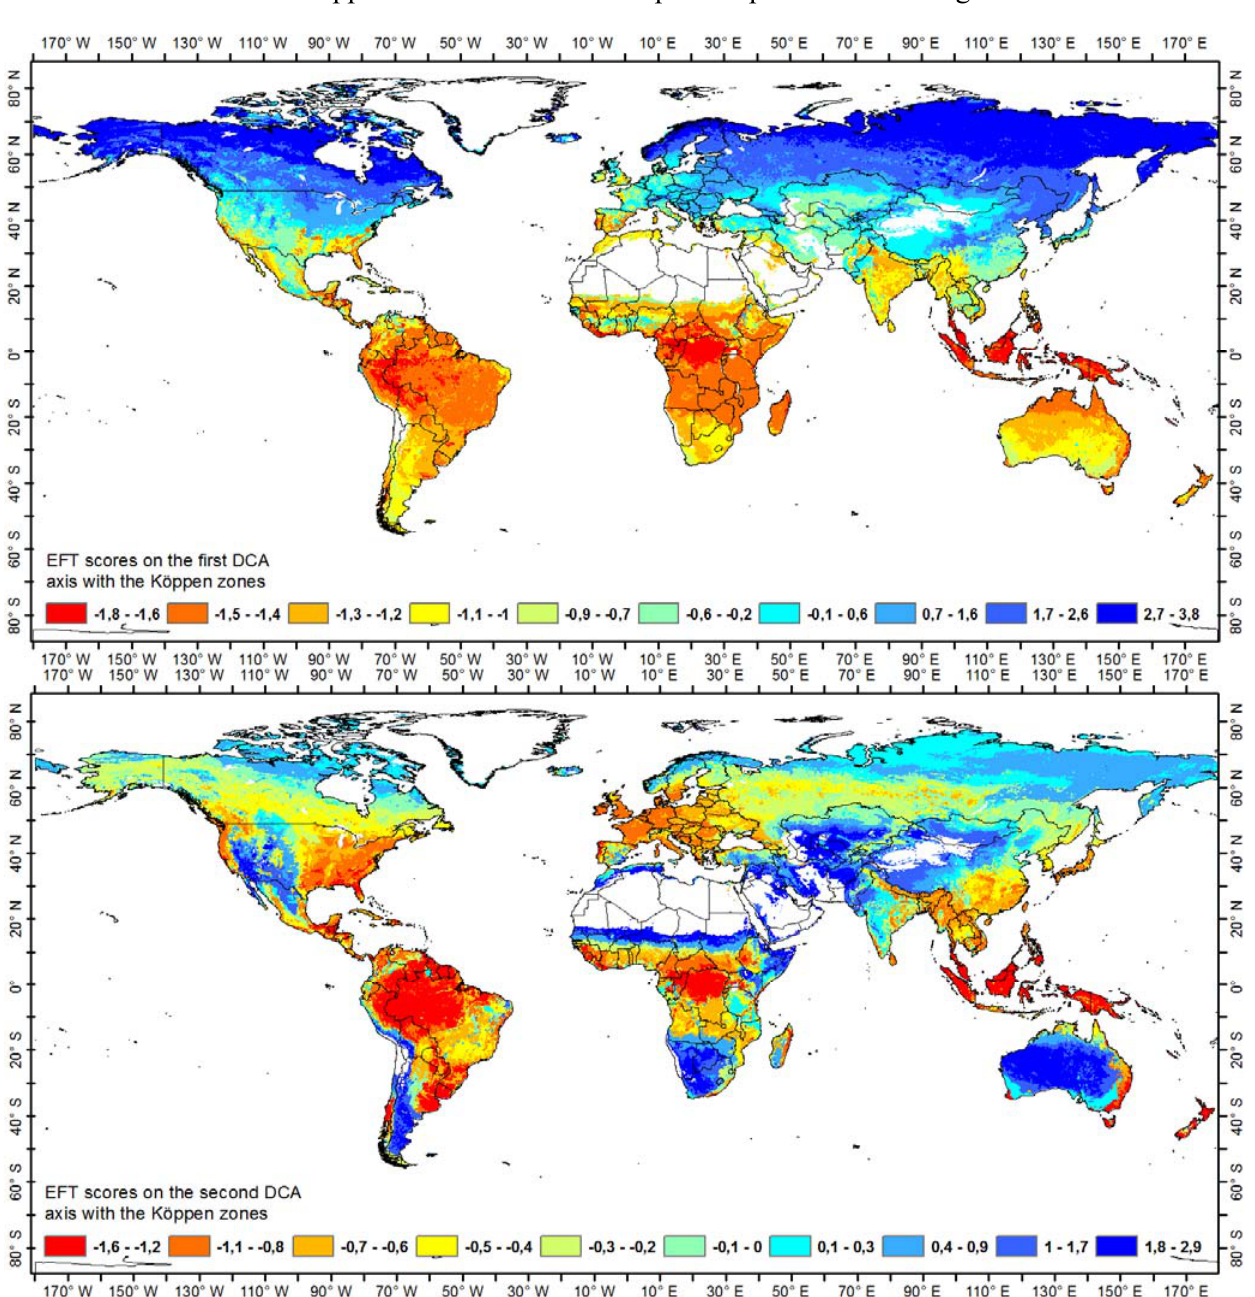
Figure 7. Spatial patterns of the first ( top ) and second ( bottom ) axis derived from DCA of the EFTs with the Köppen zones. White areas represent pixels without vegetation